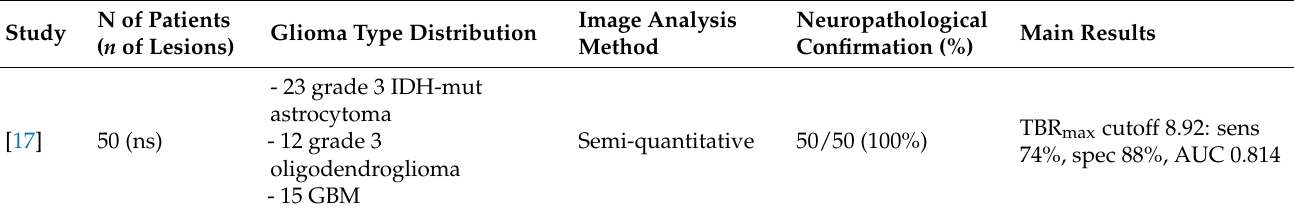
Table 4. Summary of studies investigating the diagnostic accuracy of [ 11 C]CHO PET.